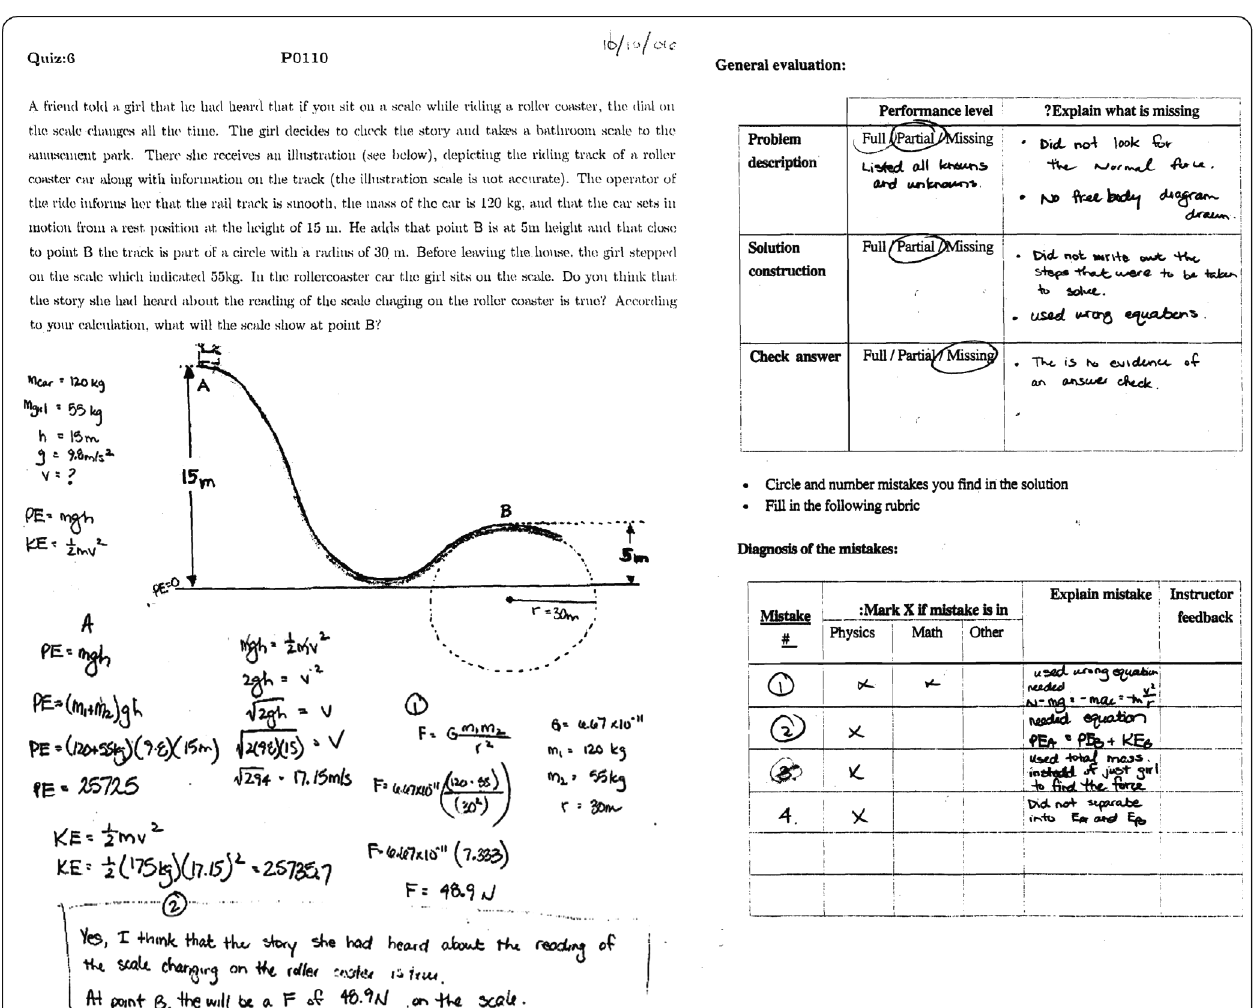
FIG. 6. Solution and self-diagnosis by a student in group B. Circled number 14 is the student’s code number. Circled numbers 1 and 2 are references labeled in the student’s self-diagnosis. Student’s mistakes are (a) defining the system or mass as the girl plus car rather rather than the normal force, (c) invoking than girl, (b) invoking universal gravitational law instead of Newton’s second law to find F g energy conservation in an incomplete form, (d) using the wrong height in calculating the potential energy, (e) regarding presentation, the student did not provide explicit subproblems and did not check their answer. Self-diagnosis: The student marks two mistakes on the solution sheet: (1) invoking the gravitational universal law, (2) defining the system or mass as the girl plus car rather than girl. In the self-diagnosis text the student refers to the following: (a) the student was not looking for the normal force (target variable) and how it should be calculated, the student notices they did not sketch a free-body diagram; (b) the student states they needed to use EC law, and how it should have been applied; c) regarding presentation, they realize they did not write the steps taken in order to solve the problem, and did not check the